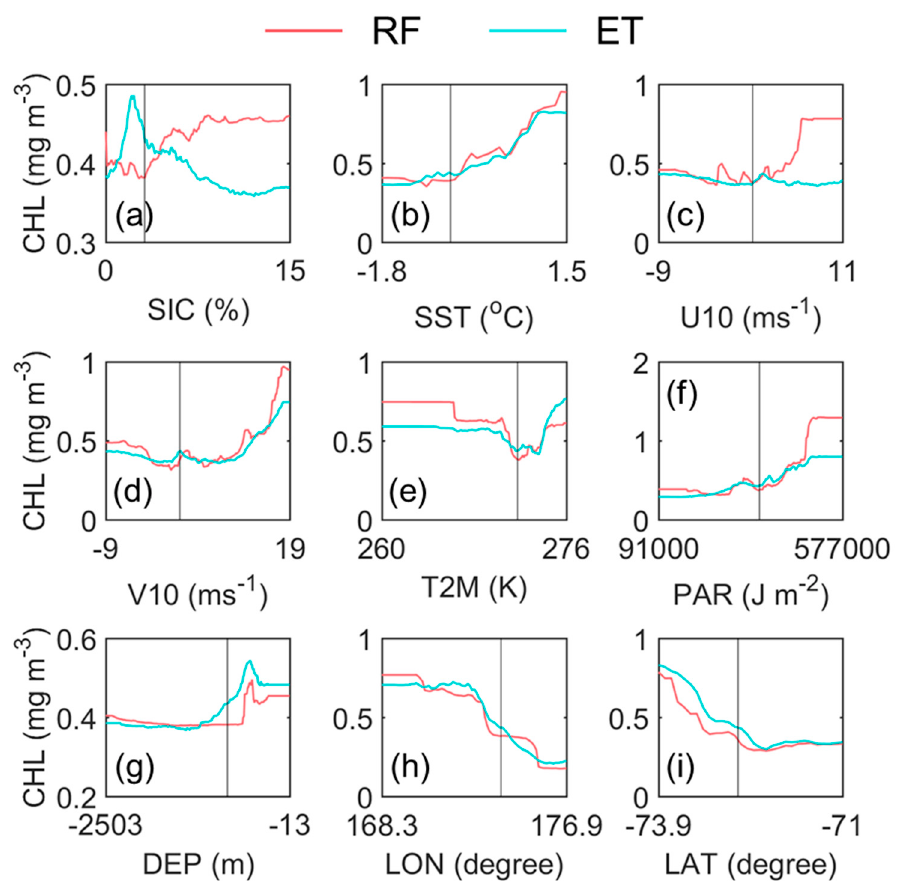
Figure 9. Partial dependence for different predictors: ( a ) SIC; ( b ) SST; ( c ) U10; ( d ) V10; ( e ) T2M; ( f ) PAR; ( g ) DEP; ( h ) LON; and ( i ) LAT. The light red and blue colors are the results from the RF and the ET models, respectively.